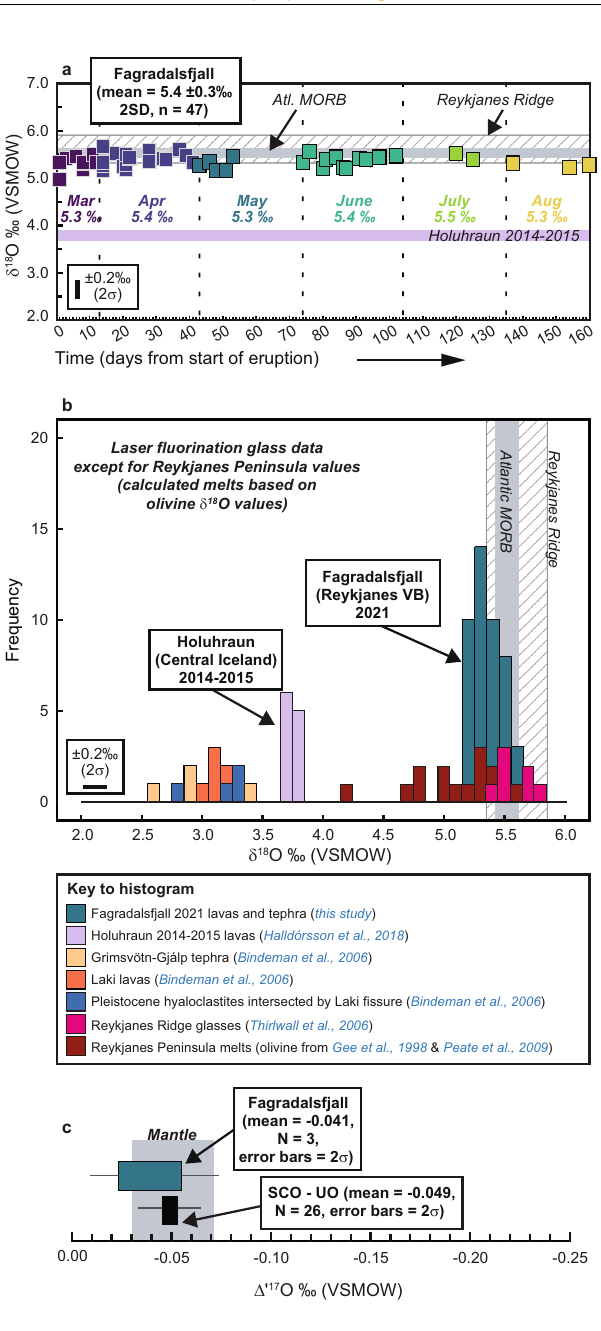
Fig. 5 Oxygen isotope results. a Timeline of δ 18 O values obtained for glasses from the 2021 Fagradalsfjall eruption over the period 20th March to 26th August 2021. Analytical uncertainty is displayed as an inset. A total of 47 analyses are presented (repeat analyses were made on four samples; in these cases the mean value is plotted), which yielded an overall mean of 5.4 (±0.3 ‰ 2 SD). The mean δ 18 O value for each month is also shown in italics. The range of values from the previous Icelandic eruption at Holuhraun (Central Iceland) in 2014 – 15 21 is provided for comparison. Note that the Fagradalsfjall data overlap Atlantic MORB 22 and Reykjanes Ridge glasses 19 . b Frequency distribution plot (frequency = number of samples) 2014 – 15 Holuhraun eruption 21 , Grímsvötn-Gjálp 17 , the 1783 – 4 Laki eruption 17 , and the Reykjanes Ridge 19 . Equilibrium melt δ 18 O values were